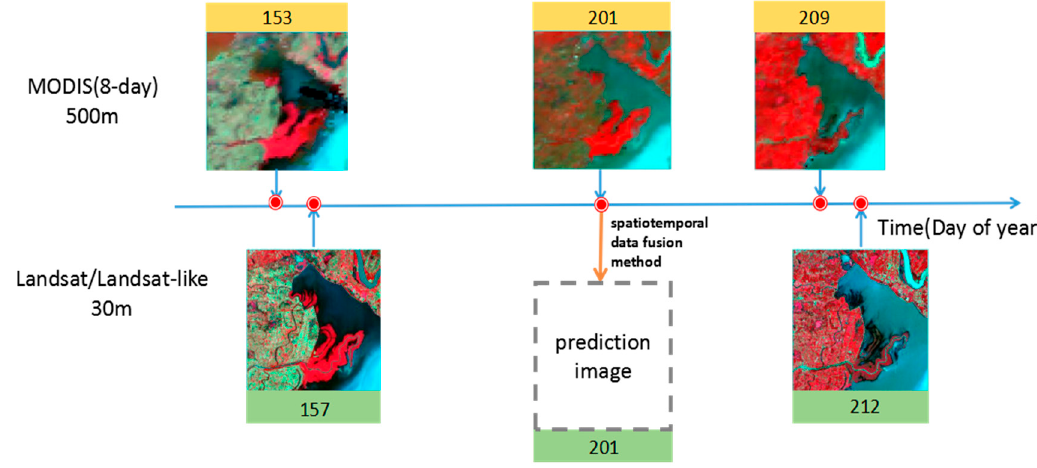
Figure 5. Date of MODIS, Landsat, and prediction Landsat-like images in the spatiotemporal data fusion implementation.